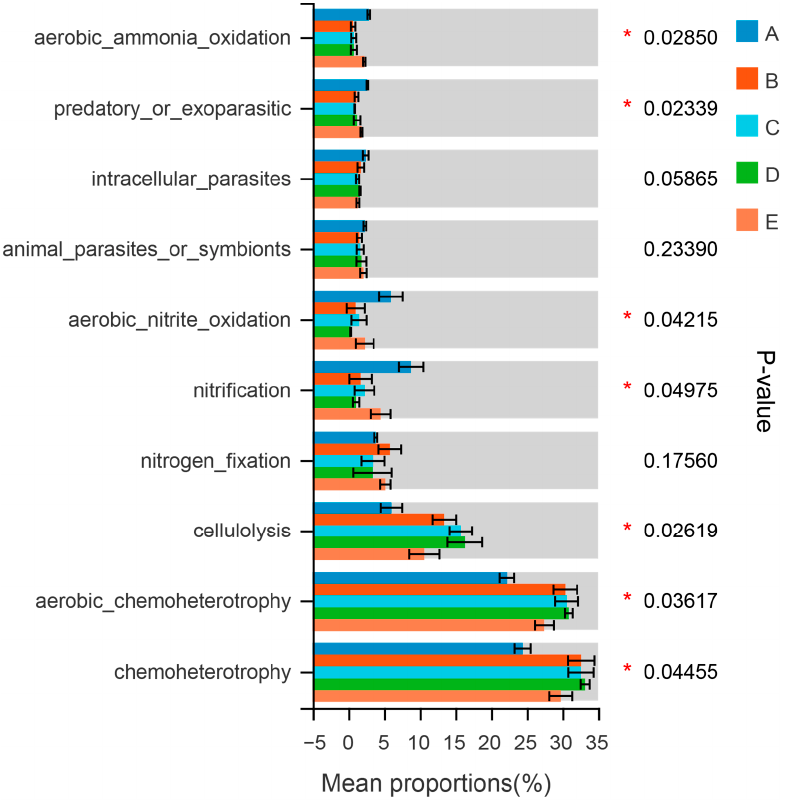
Figure 3. Differences in ecological functions of soil bacteria among 5 sites. A, C. kerrii forest; B, the lower range limit of C. pingbianense forest; C, the range center of C. pingbianense forest; D, the upper range limit of C. pingbianense forest; E, L. glaber forest. * 0.01 < p ≤ 0.05.